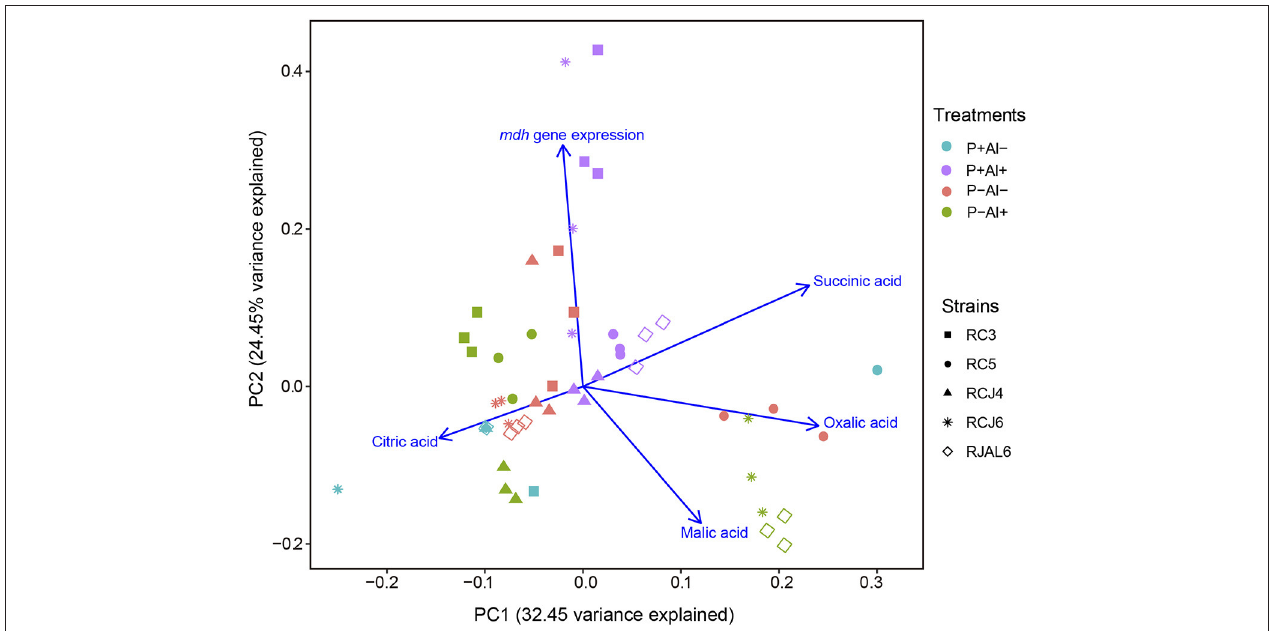
FIGURE 3 | Principal component analysis (PCA) of organic acid secreted and malate dehydrogenase (mdh) gene expression of five phosphobacteria: Klebsiella sp. RC3, Stenotrophomonas sp. RC5, Klebsiella sp. RCJ4, Serratia sp. RCJ6, and Enterobacter sp. RJAL6 grown in a modified mineral culture medium (MCM) with contrasting P and Al concentrations. P + : 1.4mM KH 2 PO 4 ; P–: 0.05mM KH 2 PO 4 ; Al + : 10mM AlCl 3 × 6H 2 O; Al–: without Al